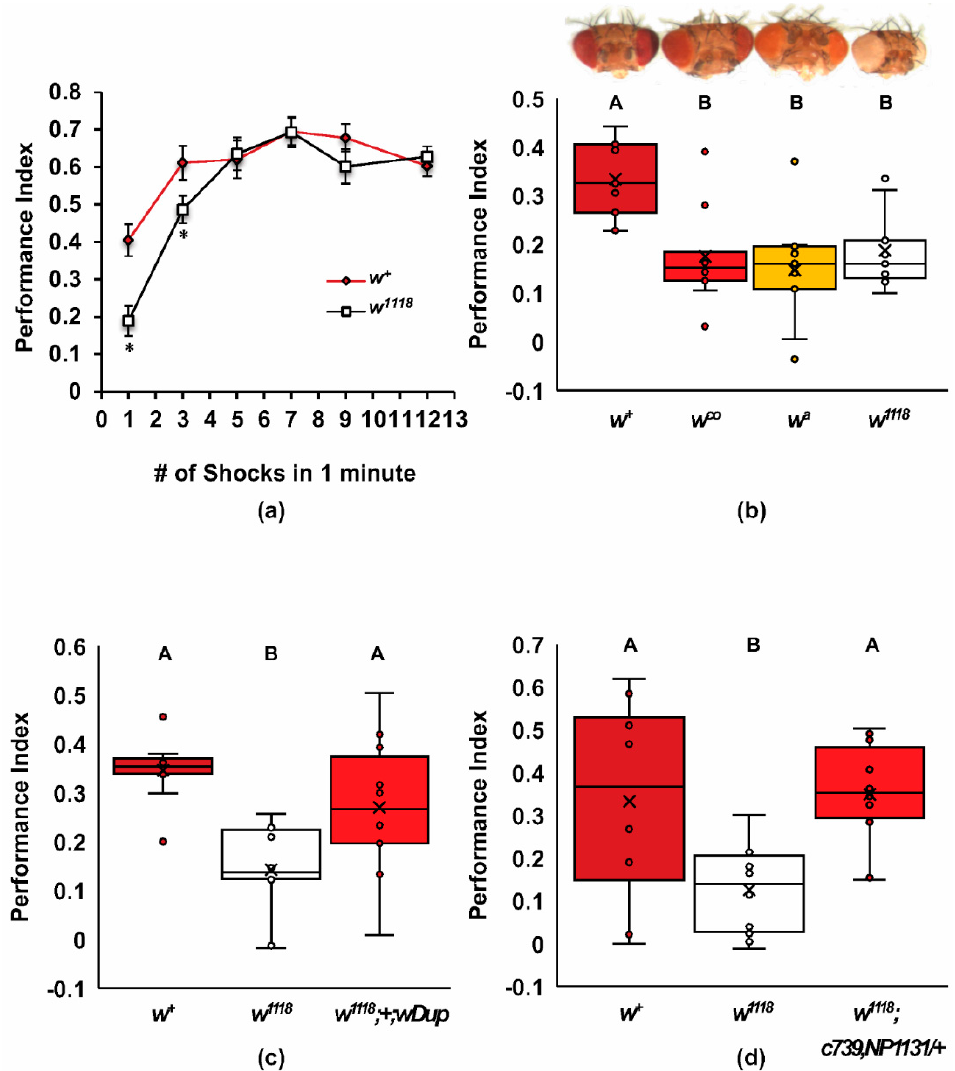
Figure 1. Mutants of white have a defect in acquisition that can be rescued by white + and mini- white transgenes. ( a ) Olfactory learning acquisition curves are shown for w 1118 mutants and wildtype Canton-S ( w + ). The w 1118 mutant has lower associative STM with one and three shock pairings to odor (two-way ANOVA, Adj. R 2 = 0.475, F 6,121 = 20.157, p < 0.0001, n = 10–13; Tukey post hoc w + versus w 1118 , p < 0.05, n = 64); ( b ) one-trial olfactory learning for wildtype and the w coral , w apricot , and w 1118 mutants are shown. Representative photos of the heads are provided above the graph to demonstrate the level of white activity remaining in eye pigment cells for each mutant. All mutants were equally poor in associative STM and significantly different from wildtype (ANOVA, Adj. R 2 = 0.321, F 3,32 = 6.524, p < 0.001, n = 9); ( c ) poor one-trial learning for w 1118 was rescued by a genomic duplication ( w 1118 ; Dp(1;3)DC050- wDup; ANOVA, Adj. R 2 = 0.356, F 2,27 = 9.022, p < 0.001; Tukey post hoc, p < 0.05; n = 10); ( d ) poor one-trial learning for w 1118 was rescued by two mini- white marked GAL4 drivers (ANOVA, Adj. R 2 = 0.254, F 2,25 = 5.590, p < 0.01; Tukey post hoc, p < 0.05; n = 8–10). In panels b, c, and d, groups that do not share letters above the box plots are significantly different from each other according to the Tukey post hoc test (* p < 0.05).